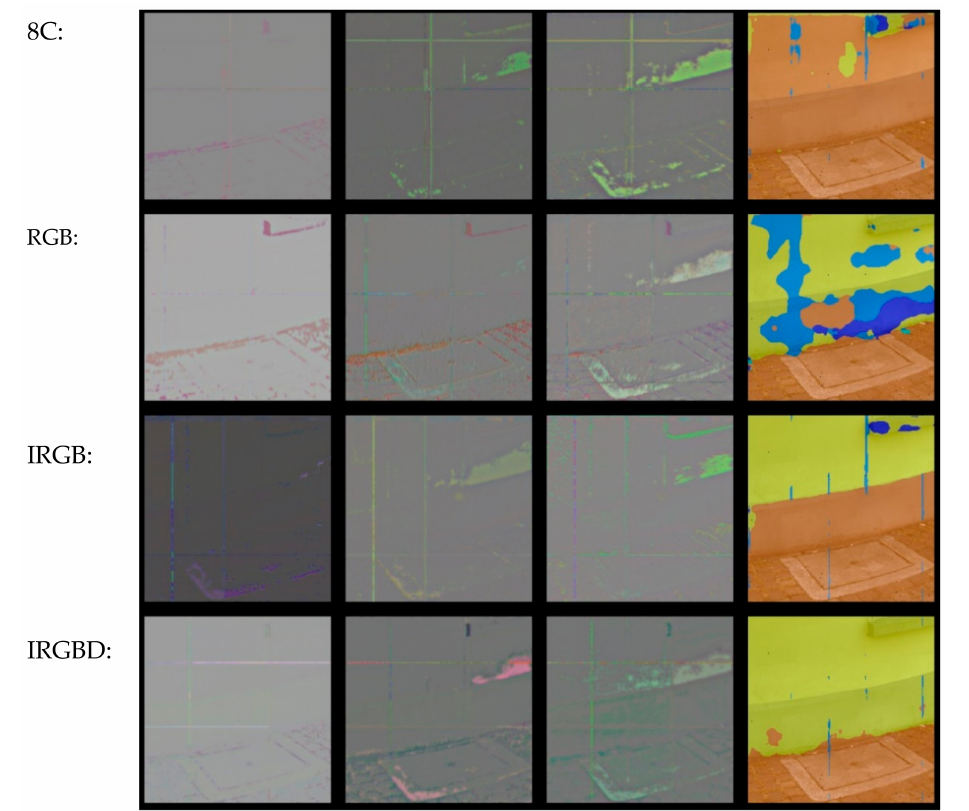
Figure 6. Feature maps and segmentation results for four combinations for the building-road joint image.